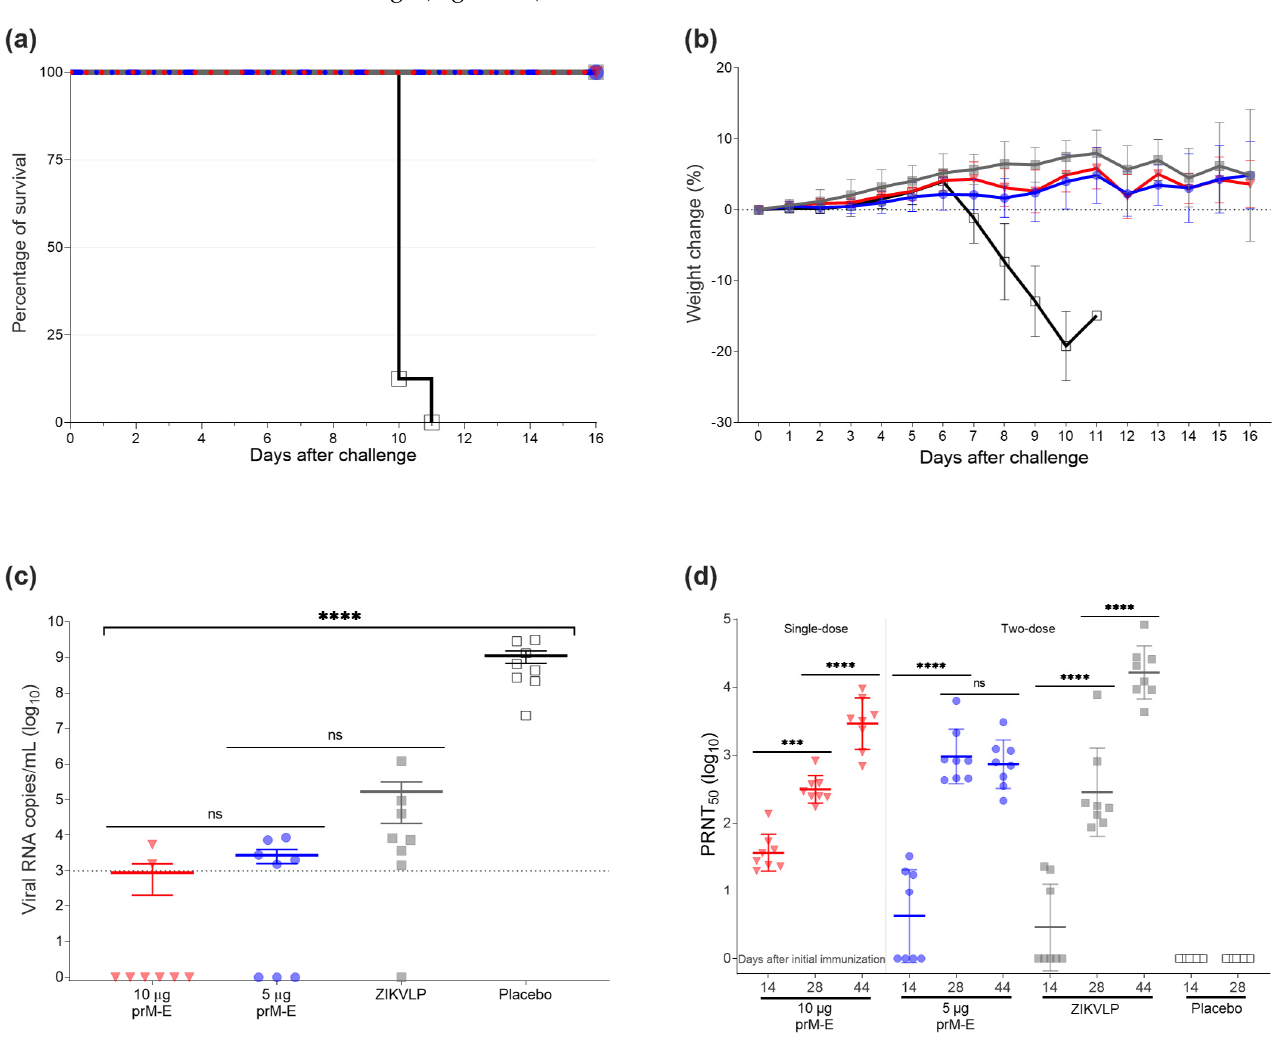
Figure 3. ZIKV prM–E mRNA-LNP vaccine protects against lethal I.M. ZIKV challenge in mice. ( a ) Survival curve of four groups of AG129 mice ( n = 8 per group) that received one single dose of 10 µ g of ZIKV prM–E (inverted triangle; red), two doses of 5 µ g of ZIKV prM–E (circle; blue), two doses of 2 µ g ZIKVLP (close square; gray), or placebo injection (open square; black) 14 days apart. Four weeks later, on day 28, they were infected I.M. with 100 PFU of ZIKV. ( b ) Percentage body weight change (mean ± SD) of challenged animals over a period of 16 days post challenge. Mice were euthanized once they showed severe clinical signs of disease or lost 20% of body weight. A single placebo-immunized mouse was euthanized on day 11. ( c ) Viral load (mean ± SEM) measured by qRT-PCR 3 days after the challenge. ( d ) Neutralizing antibody titers (geometric mean ± geometric SD) measured in serum before second immunization (day 14) and challenge (day 28), and 16 days after challenge (day 44). Raw data used for the figures are available in the Supplementary Materials. Dashed line shows the limit of detection; *** p < 0.001, **** p < 0.0001, ns = not significant. One-way ANOVA followed by Tukey’s multiple comparisons test or two-way ANOVA followed by Šid á k’s multiple comparisons test was performed using GraphPad Prism for viral load and neutralizing antibody titers, respectively. These tests were performed after the data were log-transformed and assessed for normality using a QQ